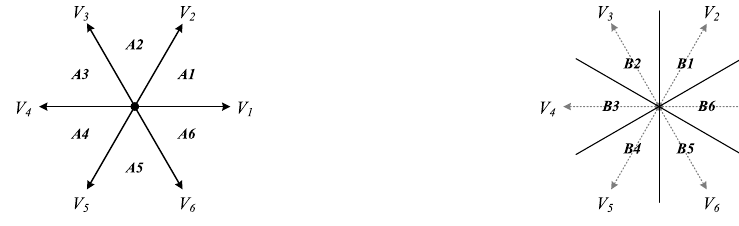
Figure 3. Definition of A- and B-regions on the space vector (SV) diagram.